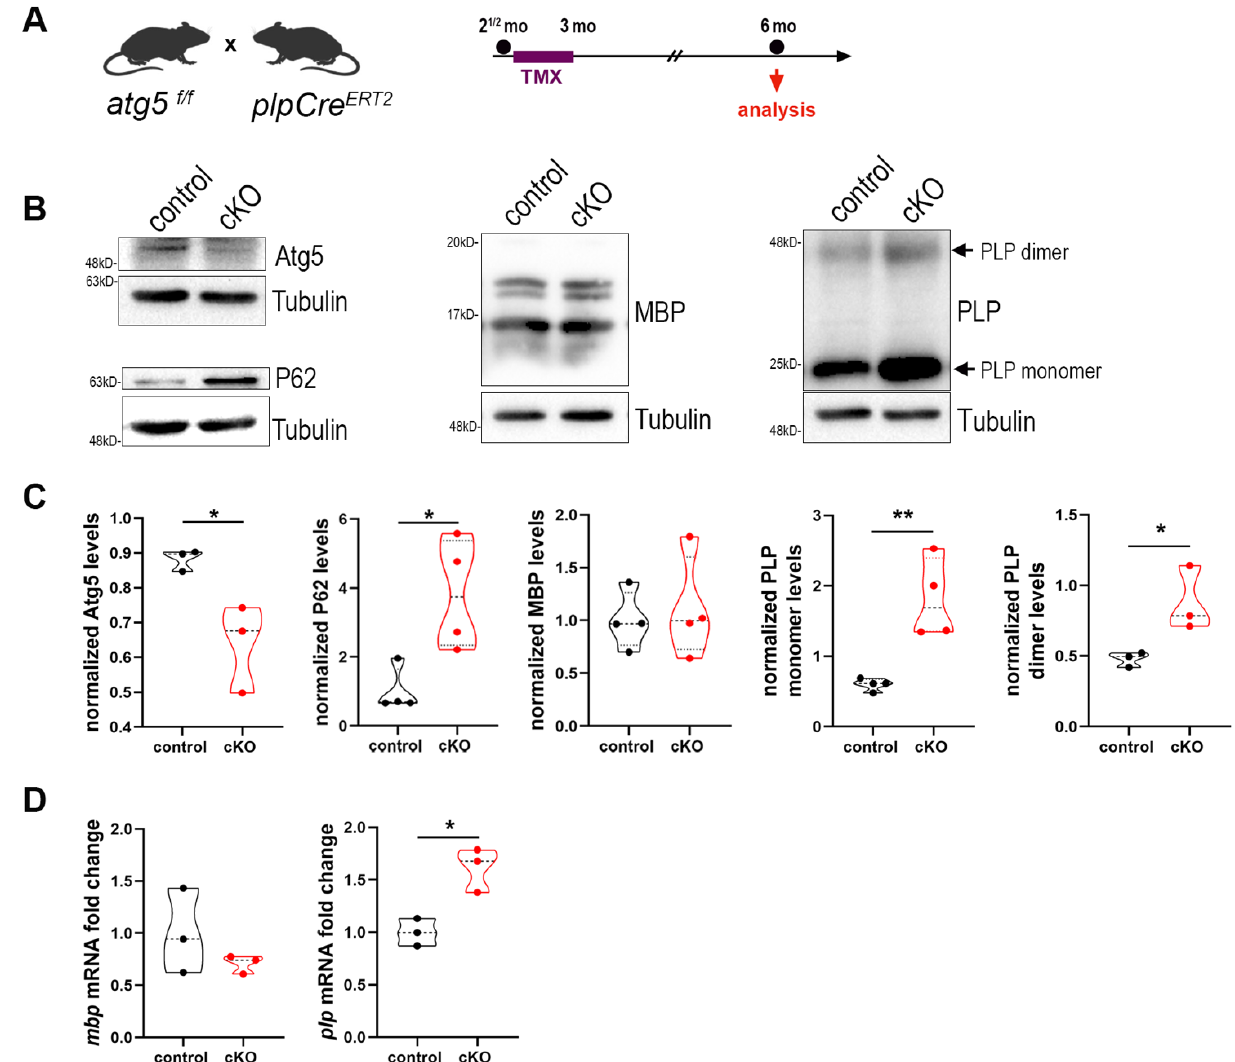
FIGURE 2: Blockage of autophagy leads to increased plp mRNA and protein levels. (A) Schematic illustration of the experimental protocol used for tamoxifen (TMX) induction and analysis in the plpCre ERT2 ; atg5 f/f mice. All animals were injected i.p. with 1 mg of TMX per day at the age of 2.5 months for 10 days with two days break in between. The analysis was performed at 6 mo. (B) Western blot analysis with antibodies against Atg5, P62, PLP and MBP proteins in optic nerve lysates of 6mo control and cKO mice. Representative images of a single experiment are depicted. (C) Quantification of normalized protein levels of “B”. (D) Quantification of quantitative real-time PCR in mouse optic nerves of 6mo control and cKO mice. Data information: Data are shown as mean ± SEM. N=3-4 animals per genotype. Student’s t-test was used to de- termine statistical significance between control and cKO protein and mRNA levels. *p < 0.05, **p ≤